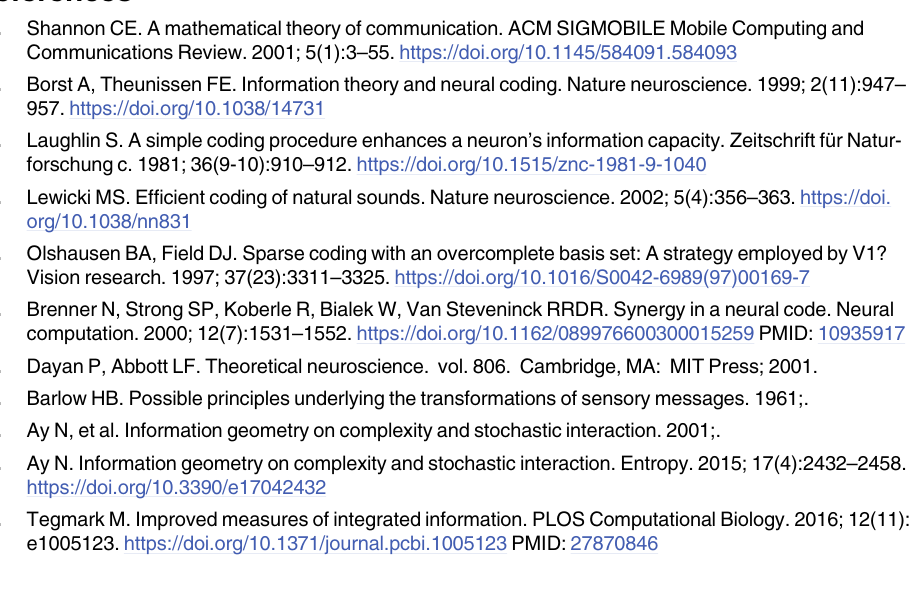
S8 Fig. Spectral clustering accuracy in large autogregressive systems. (PDF) S9 Fig. Surrogate analysis of monkey ECoG results.